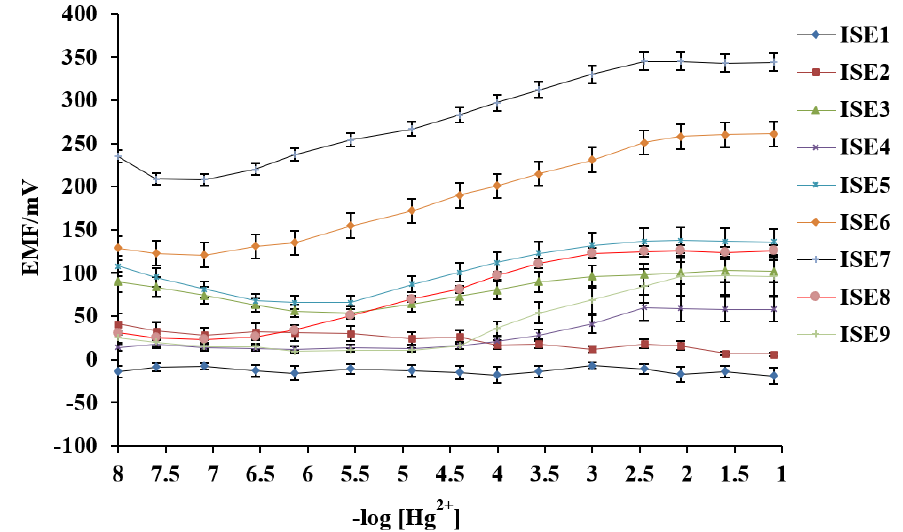
Figure 1. The influence of membrane composition on the potential response of the Hg 2+ -ISEs.